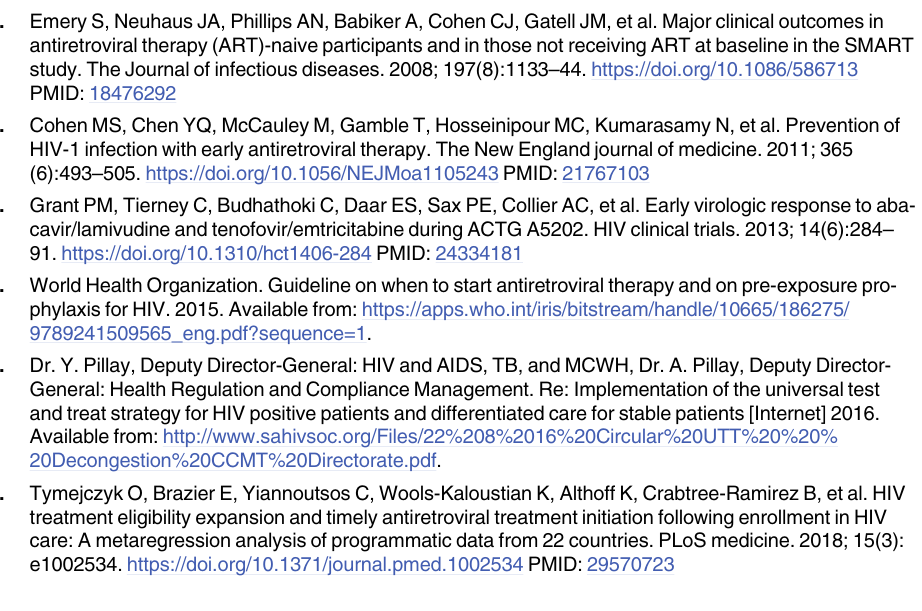
S2 Table. Hazard ratios (HR) for hypothesized predictors of time to ART initiation (adjusted for clinic and confounders) (N = 153) stratified by